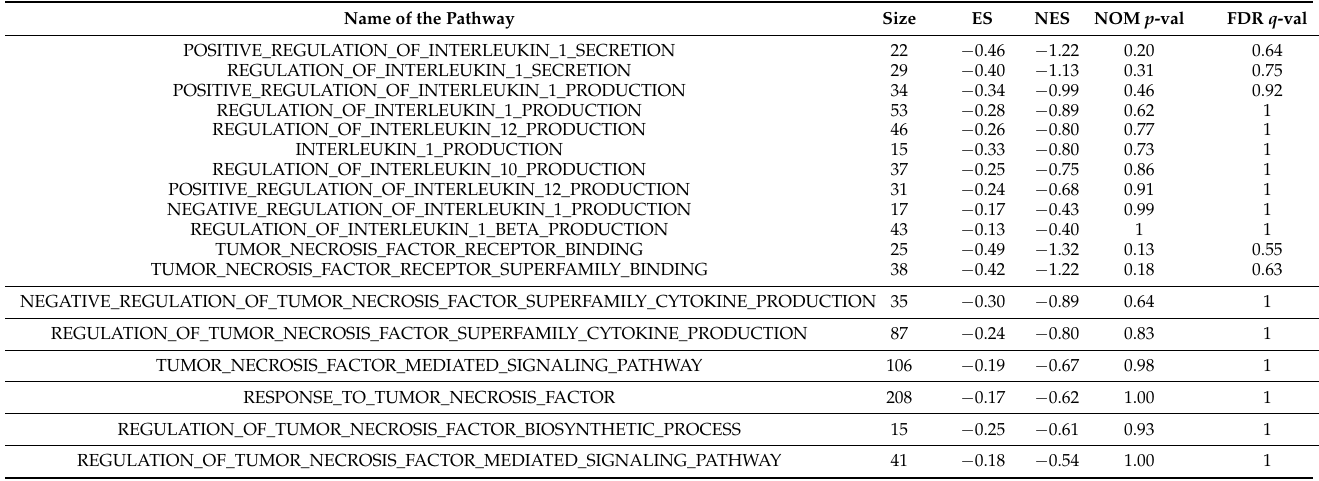
Table 5. Gene set enrichment analysis in M.BCG vs. P.BCG. ES: Enrichment Score; NES: